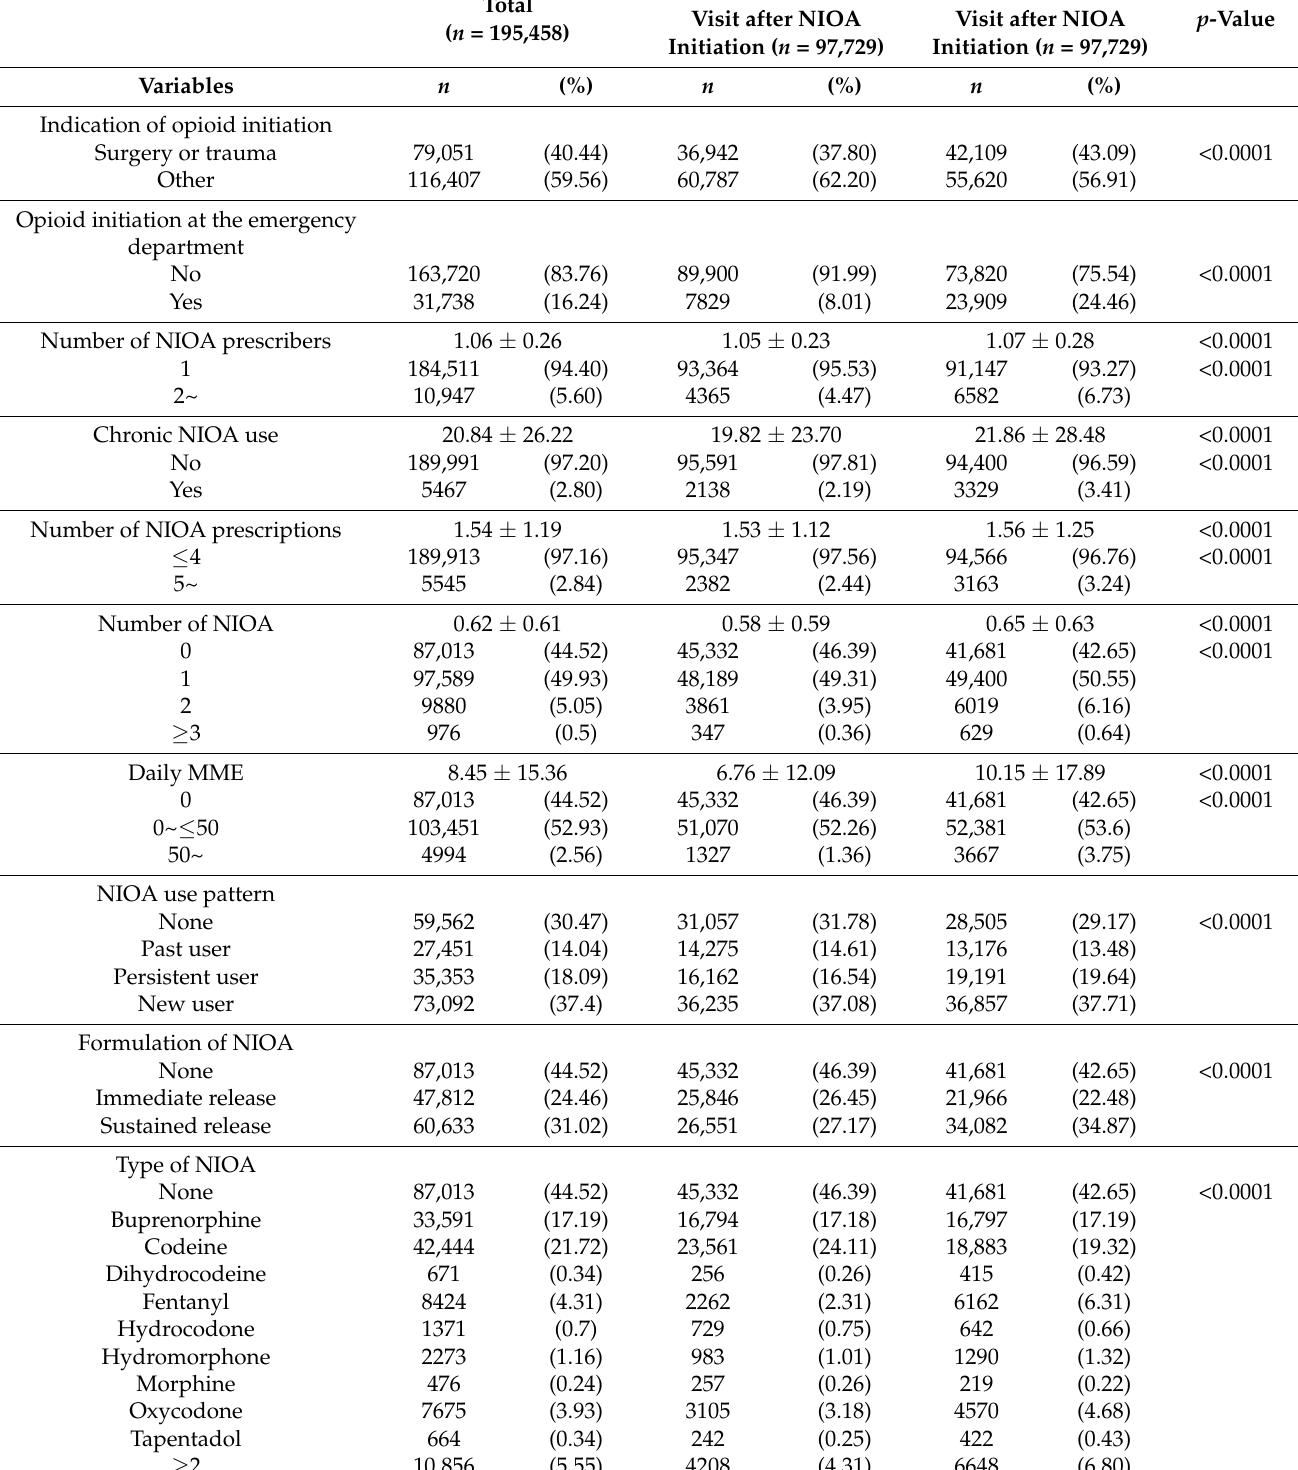
Table 2. Patterns of NIOA use in patients initially prescribed NIOA for non-cancer